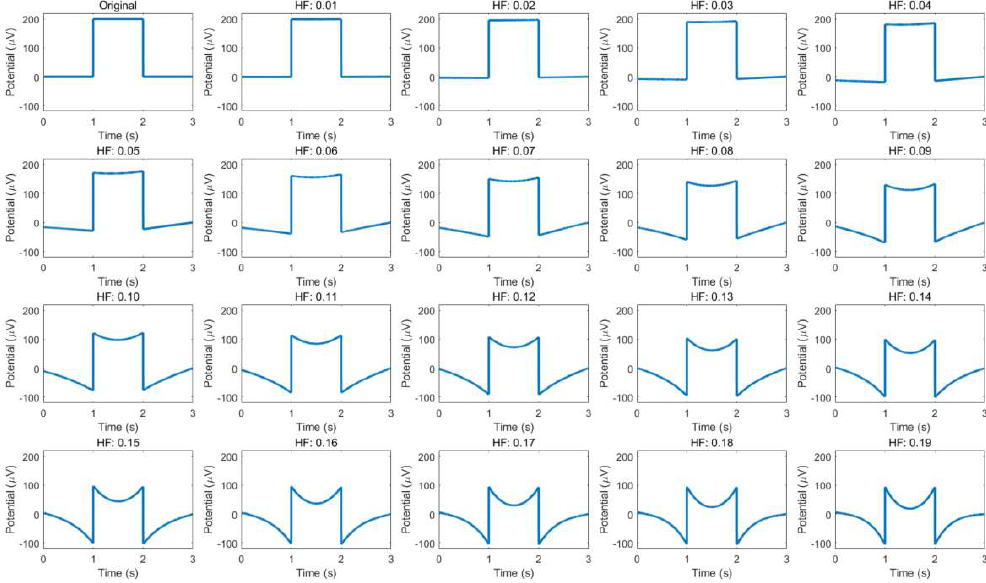
Figure 5. Artificially generated eye movement signal and the changes after applying high-pass filters of different cut-off frequencies. The cut-off frequencies are noted above each axis, while the original signal is displayed in the top-left.